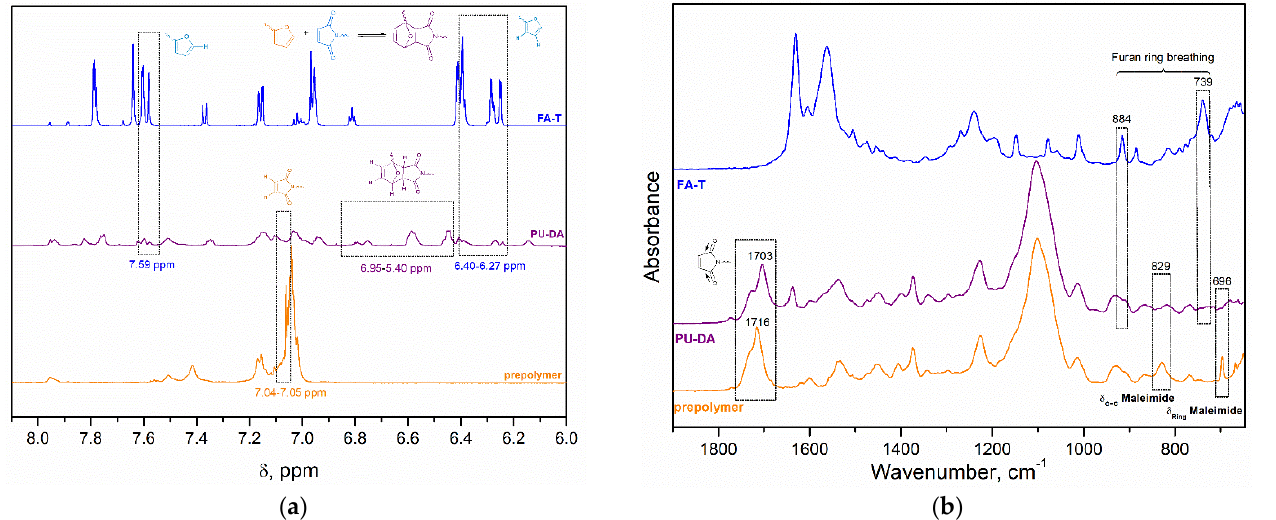
Figure 3. NMR ( a ) and IR ( b ) spectra of prepolymer, PU-DA, and FA-T. A comparison of the IR spectra was more illustrative. Bands of the asymmetric vibra- tion of C=O groups conjugated with the maleimide cycle in prepolymer (1716 cm −1 ) and PU-DA (1703 cm −1 ) spectra were preserved. A small red shift of the band may be caused by the breaking of the C=O and maleimide heterocycle conjugation via the DA reaction occurring [37]. On the other hand, bands of the double bond (829 cm −1 ) and deformational vibration of the cycle (696 cm −1 ) in maleimide completely disappeared, which indicates DA reaction occurrence [38]. The disappearance of the bands at 884 and 739 cm −1 associ- ated with the furanic ring also proves the cross-linked via DA reaction PU formation [39].